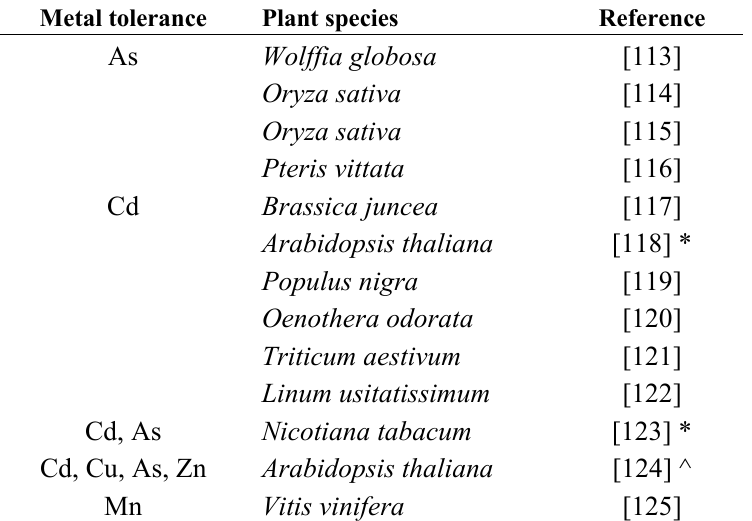
Table 2. Selected publications from 2012 on plant heavy metal tolerance conferred by phytochelatins. All papers relate to endogenous phytochelatin synthesis except for those with